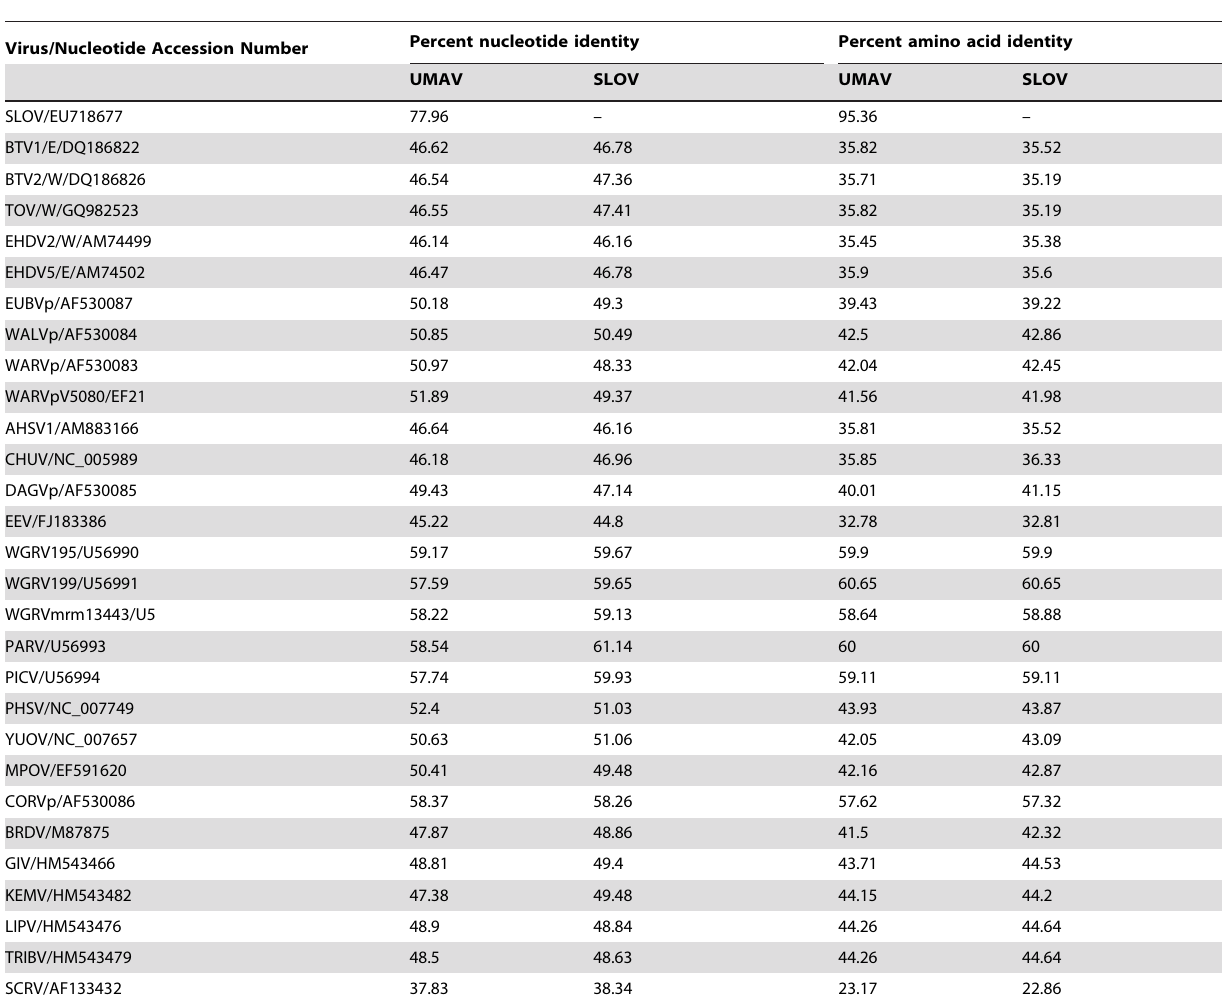
Table 3. Percent nucleotide (nt) and amino acid (aa) identities of Seg-2 (T2 protein) of UMAV and SLOV with other orbiviruses.